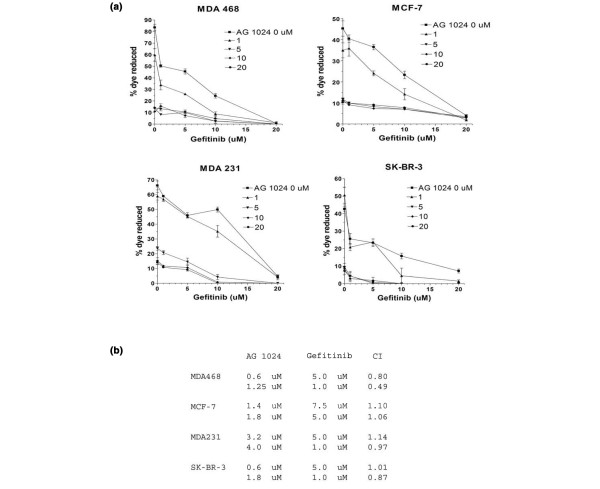
Inhibition of breast cancer cell growth by AG1024 and gefitinib singly and in combination. (a) Cells in exponential stages of growth were exposed to increasing concentrations of inhibitors for 72 hours in media containing 1% fetal bovine serum. Triplicates were used for each dose combination for each experiment. (b) Proliferation combination index (CI) values were calculated using the classic isobologram equation [55] and indicate synergy (CI < 1) or additivity (CI approximately 1).